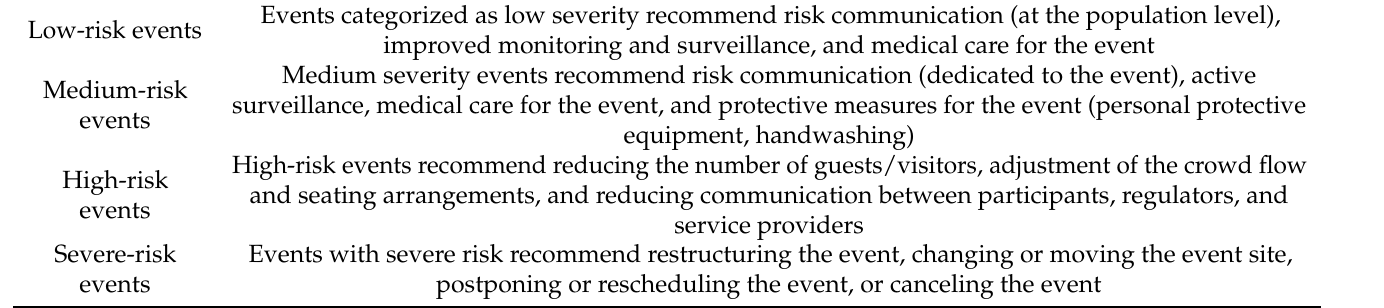
Table 3. Risk classification and preparedness of Saudi SALEM